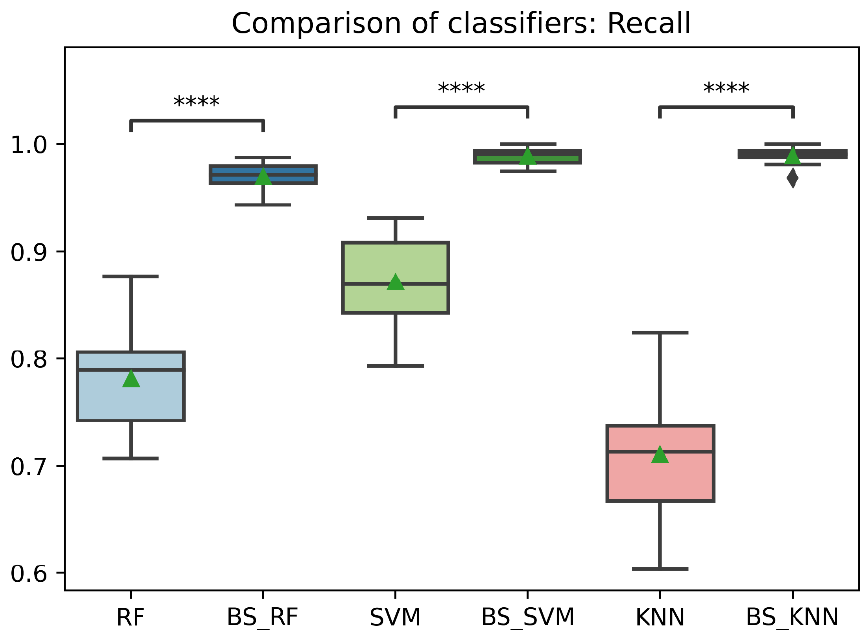
Figure 10. Comparison of recall between classification models with imbalanced and oversampled data. RF = Random Forest; BS_RF = Borderline-SMOTE Random Forest; SVM = Support Vector Machine; BS_SVM = Borderline-SMOTE Support Vector Machine; KNN = K-nearest Neighbors; BS_ KNN = Borderline-SMOTE K-nearest Neighbors; ****: p ≤ 0.0001.